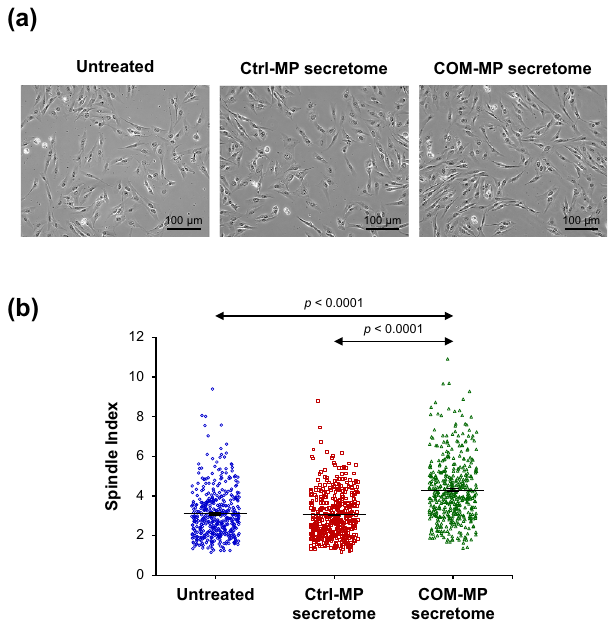
Fig. 5 Effects of secretome derived from COM-exposed macrophages (COM-MP) on morphology and spindle index of BHK-21 renal fi broblasts. BHK-21 cells were incubated in fresh serum-free medium without any treatment (untreated control) or in fresh serum-free medium mixed 1:1 (v/v) with secretome derived from the control macrophages (Ctrl-MP secretome) or COM-MP secretome for 24 h. a Morphology of the BHK-21 renal fi broblasts. b Their spindle index was calculated from at least 100 cells in ≥ 10 random high-power fi elds (HPFs) for each sample using Formula 2. The data were obtained from three independent experiments using different biological replicates and the bars indicate mean ± SEM (all the source data are presented in Supplementary Data